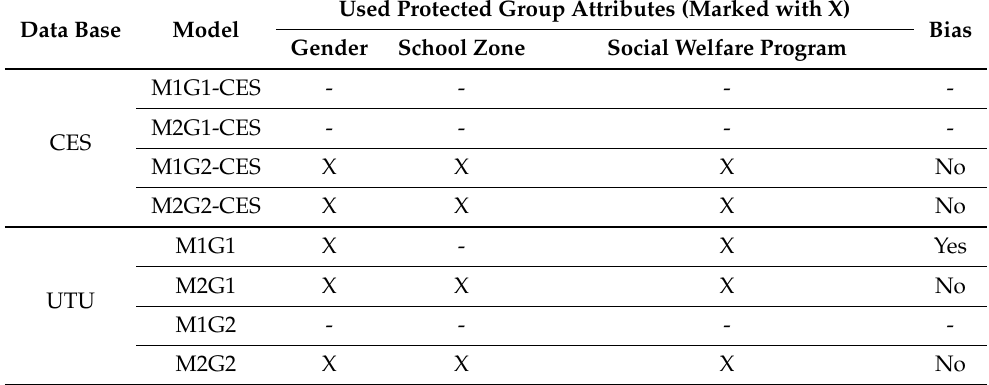
Table 7. Protected group attributes and the existence of bias.